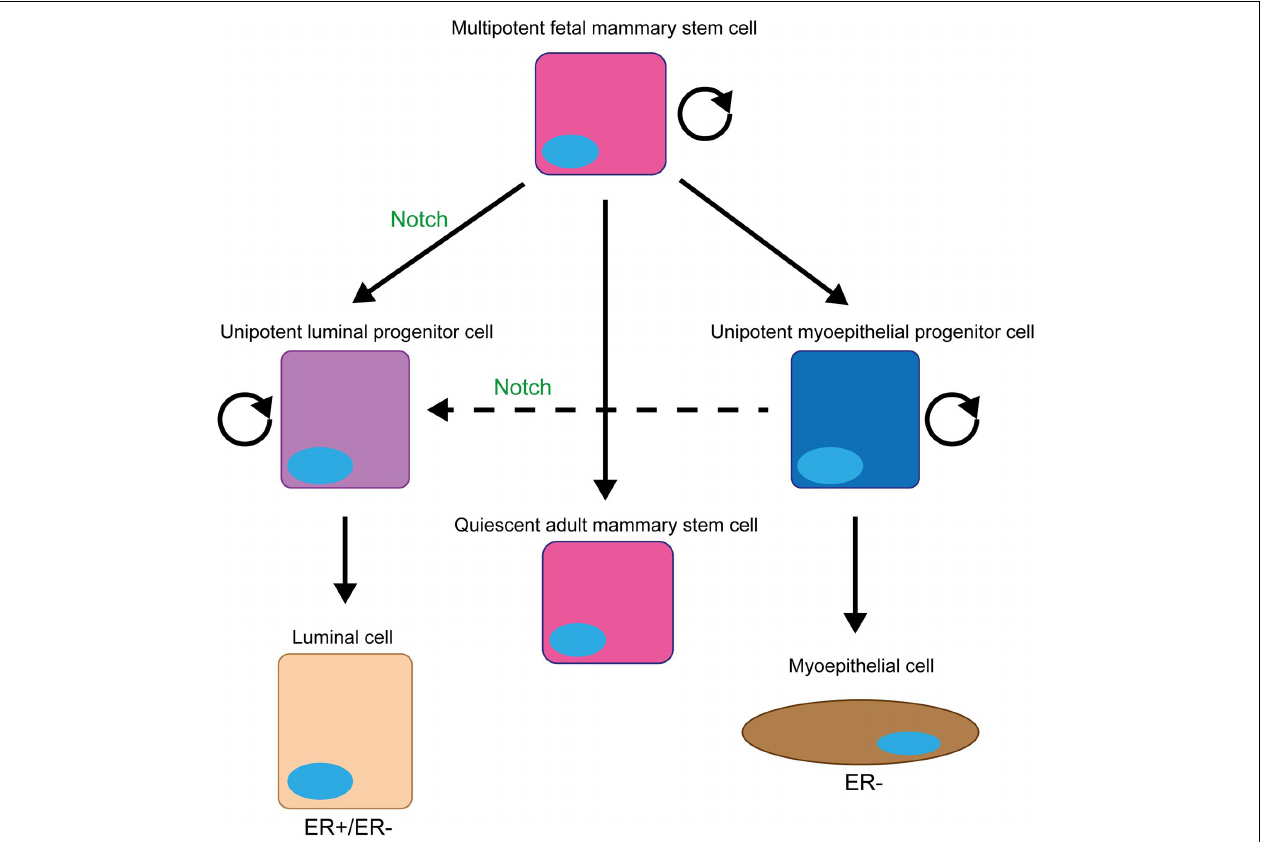
FIGURE 2 | Notch signalling promotes and maintains the luminal progenitor cell fate in the mammary gland. The initial stem cell found within the mammary gland (fMaSC) is multipotent and can form both luminal and myoepithelial cells. However, by late embryogenesis, the gland contains two unipotent progenitor cells that form and maintain the luminal and myoepithelial cell layers of the ductal structures within the gland during puberty and adult life and a quiescent multipotent adult MaSC that is only reactivated upon injury (Woodward et al., 2005; Watson and Khaled, 2020). Notch signalling promotes the differentiation of the foetal MaSCs into the unipotent luminal progenitor cell and prevents this cell differentiating into mature luminal epithelial cells to maintain the population (Dontu et al., 2004; Buono et al., 2006; Bouras et al., 2008; Raouf et al., 2008; Lafkas et al., 2013; Šale et al., 2013; Rodilla et al., 2015; Zhang Y. et al., 2016; Lilja et al., 2018). Upon ablation of the luminal epithelial cells in the adult mammary gland, Notch signalling can also promote the conversion of unipotent myoepithelial progenitor cells into unipotent luminal progenitors to repopulate the luminal lineage (Centonze et al.,